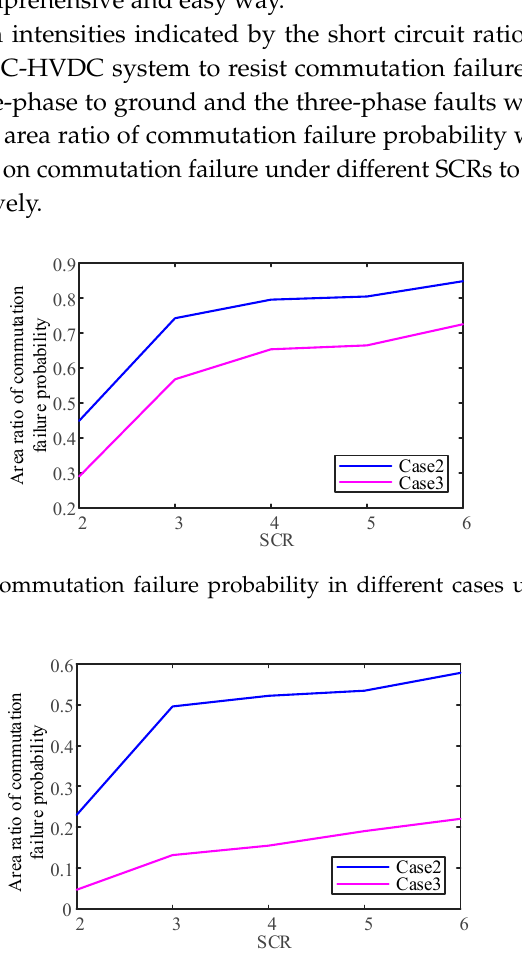
Figure 10. Area ratio of commutation failure probability in different cases under three phase fault.